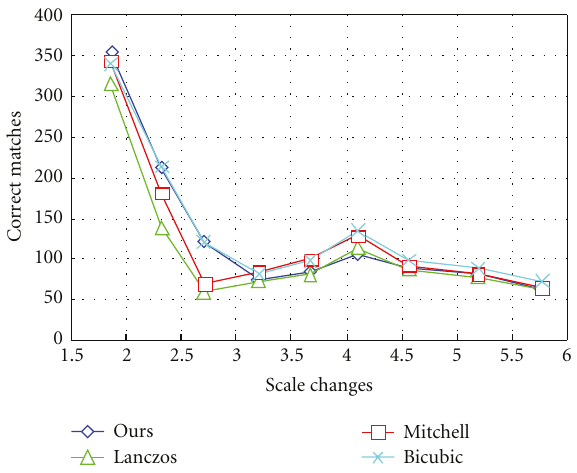
Figure 8: Performance evaluation of di ff erent downsampling